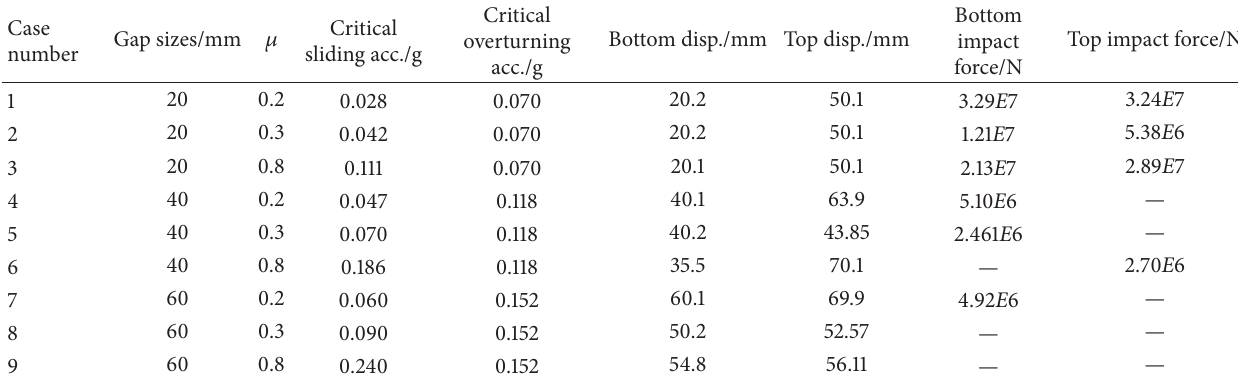
Table 4: The maximum results of the 9 sets of parameters